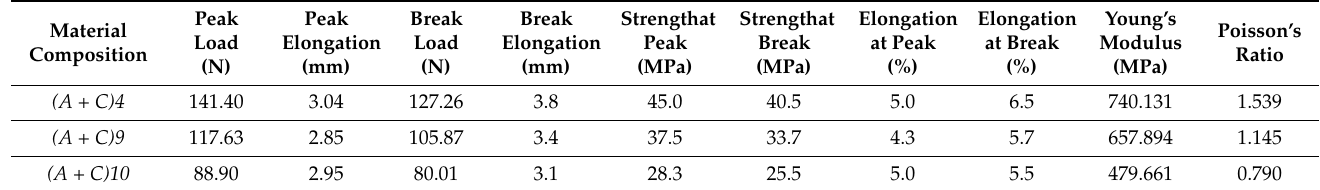
Figure 12. Stress–strain curves for ( a ) (B + C)4 , ( b ) (B + C)9 , ( c ) (B + C)10 composite samples. Thirdly, the double-sized compositions of (A + C)4, (A + C)9 , and ( B + C ) were prepared and filaments were used for testing. It was observed that peak load, peak elongation, break load, break elongation, strength at peak, strength at break, % elongation at peak, and % elongation at break were maximum for the composition of the 1% copper. It can be further noted that the ultimate tensile strength was decreasing continuously with the addition of double-size copper particles (100 and 400 mesh) in ABS. All of the data in tabulated form is shown in Table 12 with stress–strain curves in Figure 13a–c. Table 12. Tensile testing of A and C copper and ABS at different